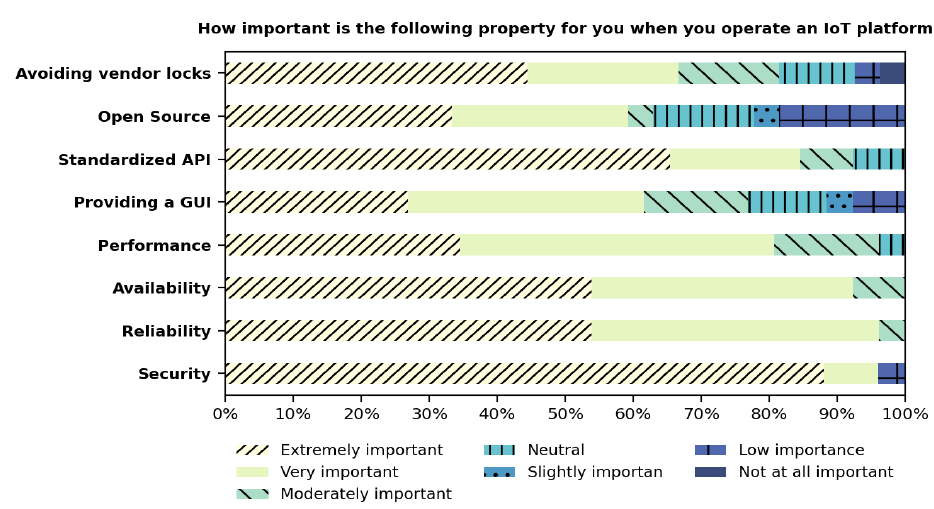
Figure 6. Responses to survey question list the eight most important features that should be offered by the IoT